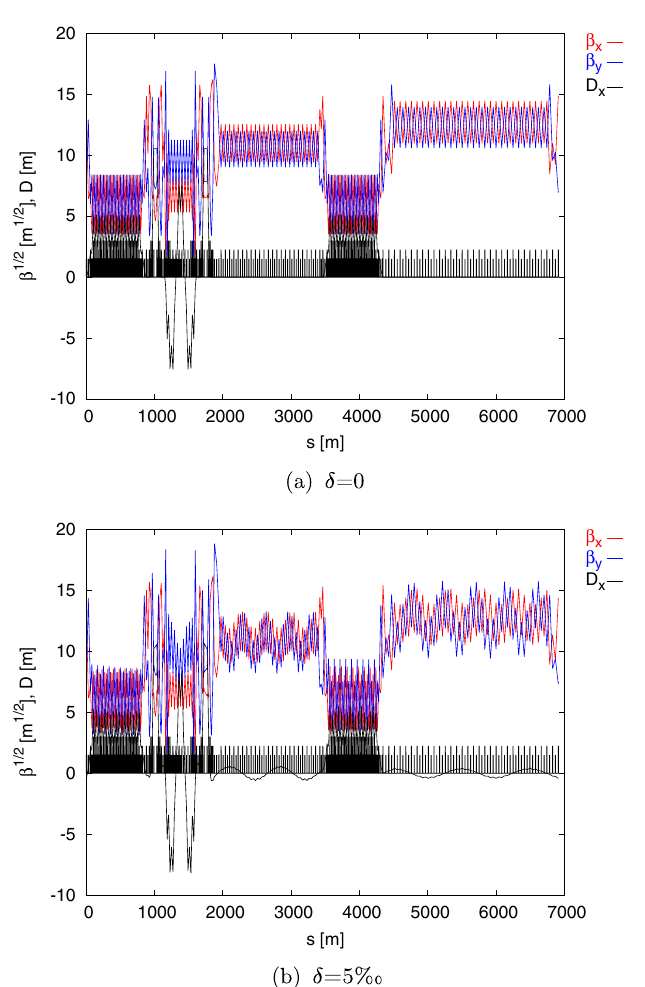
FIG. 36. Optical functions in the beta-beam decay ring at the reference energy and at the injection